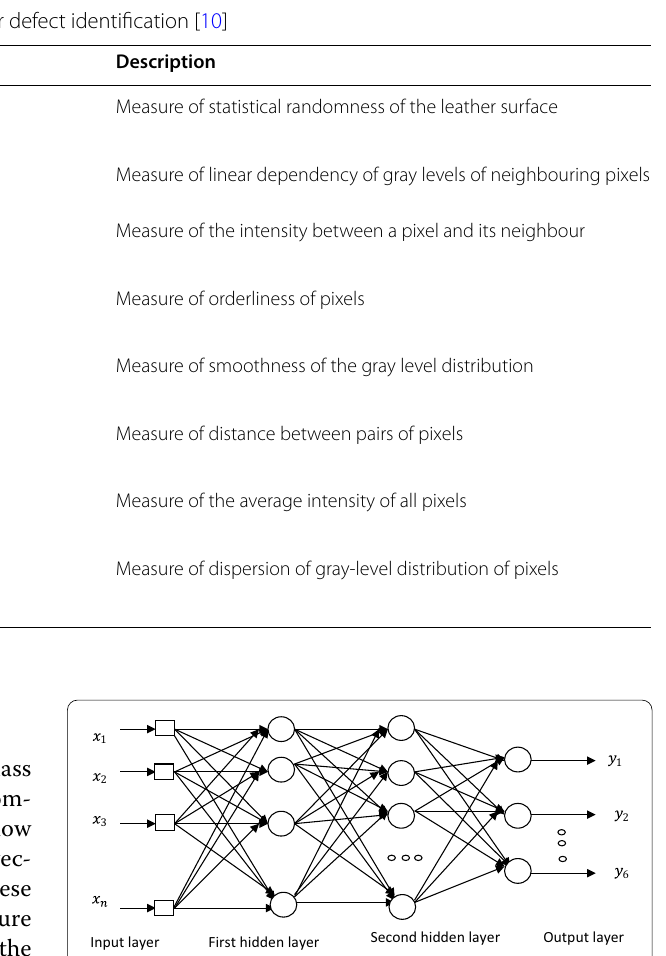
Fig. 7 Typical architecture of shallow feed-forward neural